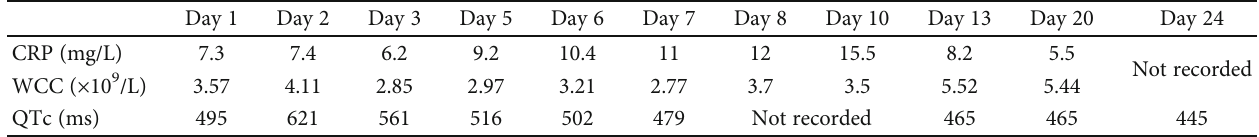
Figure 3: Shows day 24 ECG with a QTc of 445ms. Table 1: Association between in fl ammatory markers and corrected QT